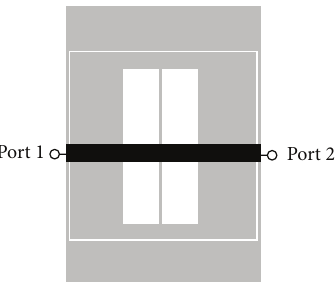
Figure 8: Microstrip line loaded with an MLC with the electric wall aligned with the line. The dimensions and the substrate are the same as those considered in Figure